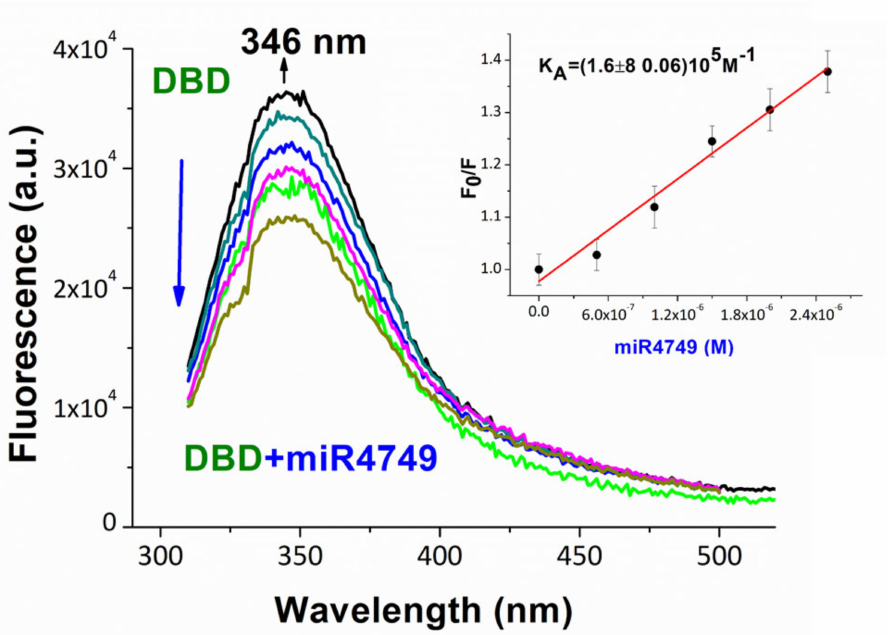
Figure 2. Fluorescence emission spectra of DBD at the concentration of 1 µ M (black line), and upon the addition of miR4749-5p at higher concentrations ranging from 0.5 to 2.5 µ M (colored lines). Samples were excited at 295 nm and the spectra were corrected for the Raman scattering of the buffer. Inset: Stern-Volmer plot of the fluorescence quenching of DBD as a function of miR4749-5p concentration, shown as black circles. The continuous red line represents the linear fit by the equation F 0 /F = 1 + K A *C[miRNA4749-5p]; the extracted constant, K A , being shown. Adapted from ref. [70].